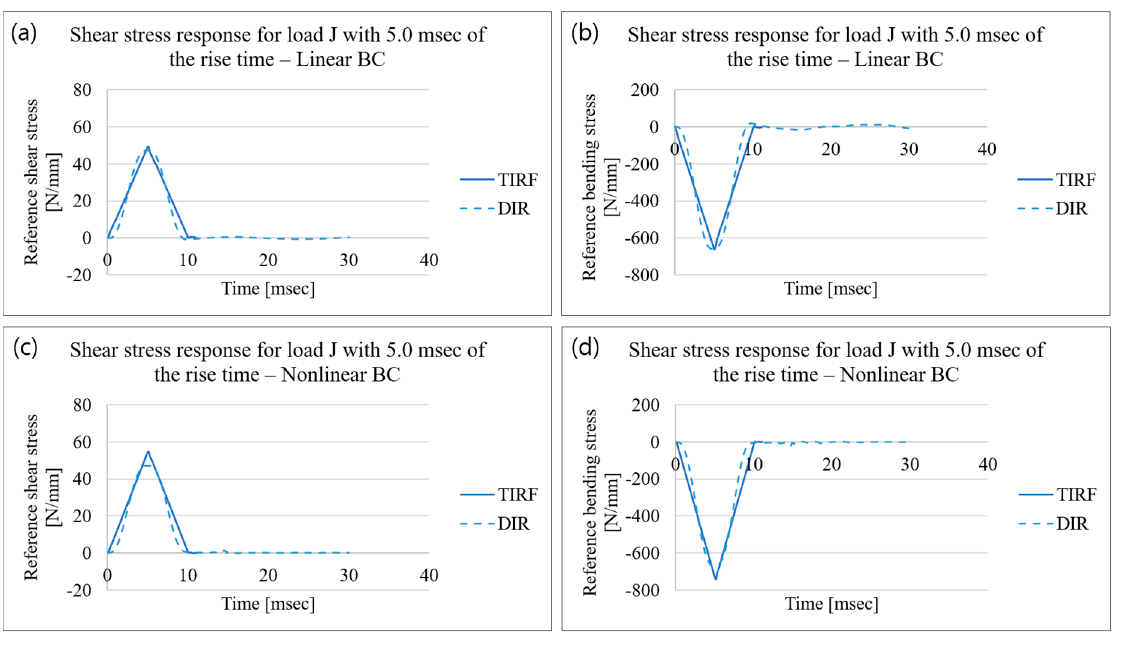
Figure 18. Reference shear and bending responses for Load X (uniform pressure 3 × 3 load case) using TIRF and DIR for impact pressure of 5.0 ms of rise time: ( a ) Reference shear responses with linear boundary conditions, ( b ) Reference bending responses with linear boundary conditions, ( c ) Reference shear responses with nonlinear boundary conditions, and ( d ) Reference bending re- sponses with nonlinear boundary conditions.